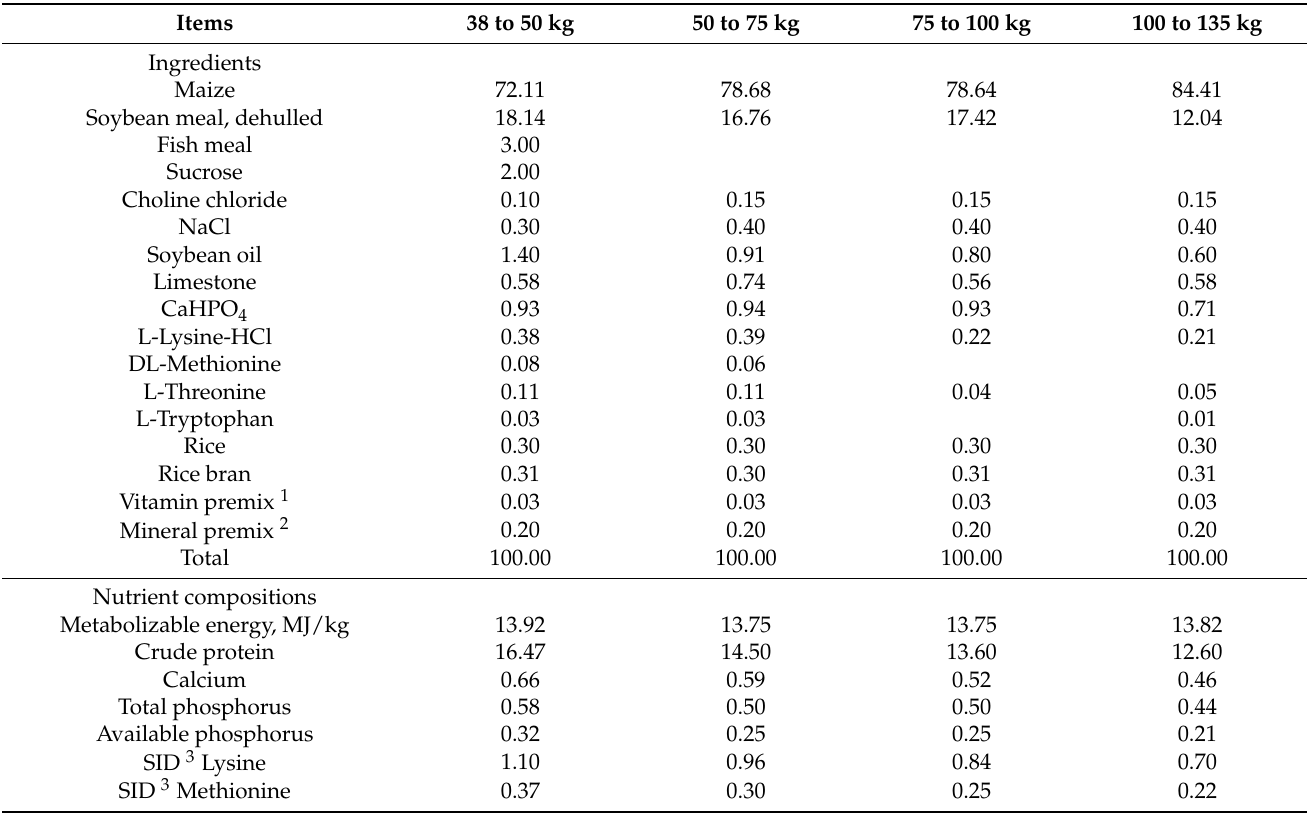
Table 2. Diet and chemical compositions of basal diets (%, as-fed